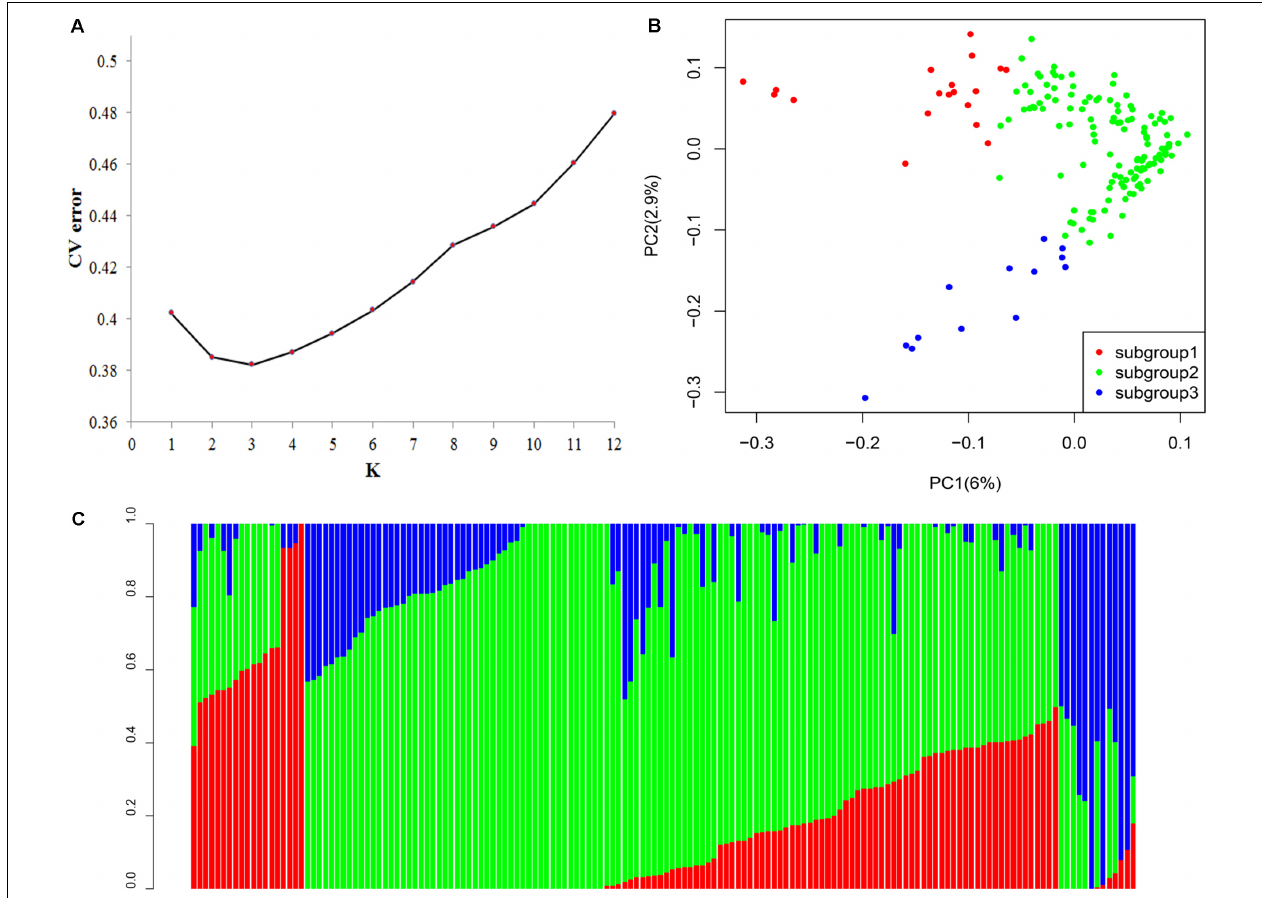
FIGURE 3 | (A) Population structure analysis on 158 cassava accessions using ADMIXTURE. Estimated cross-validation error of possible clusters ( K ) from 1 to 12. (B) Population structure based on K = 3. In the panel, each individual is indicated with a vertical bar partitioned into three colored segments, and their respective lengths represent the proportion of the individual’s genome in a given group: red, green, and blue represent subgroups 1, 2, and 3, respectively. (C) Principal component analysis (PCA) of the population for 158 cassava accessions based on 25989 SNPs and indels. One dot represents each individual; the symbol color corresponds to the assigned subgroup classification. PCA plots of the same cassava germplasm collection according to subgroups, as identified by